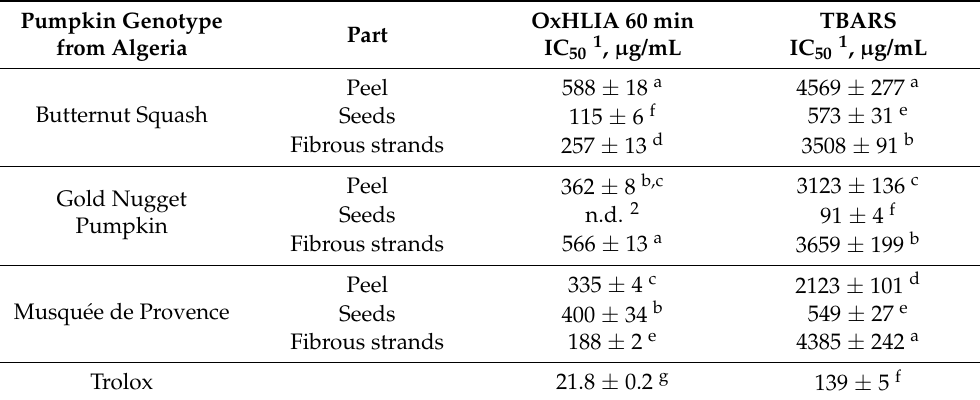
Table 5. Antioxidant activity of the byproducts of three pumpkin genotypes from Algeria, obtained through cell-based